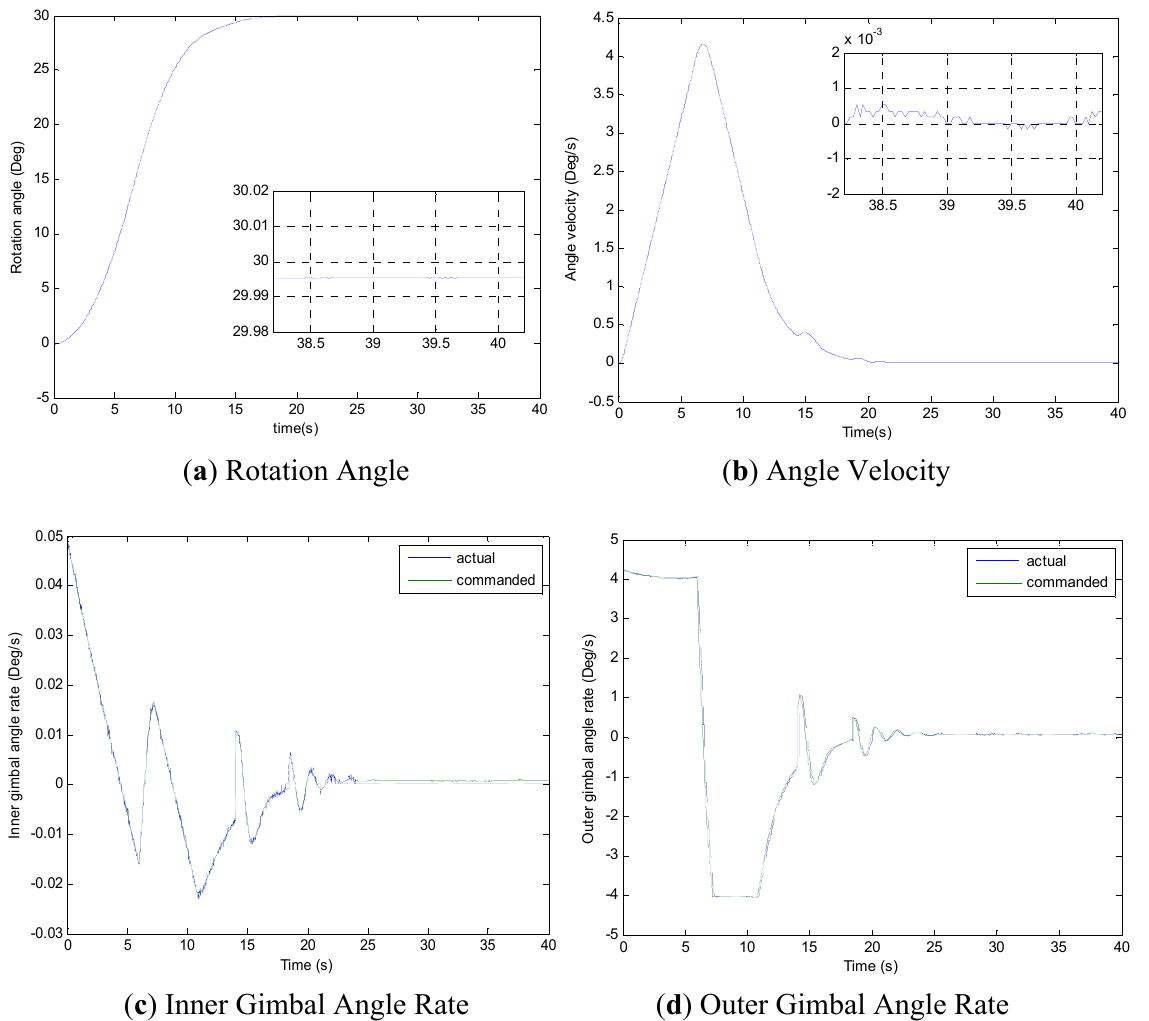
Figure 4. MSDGCMG Rotor Speed 6,000 rpm (Case